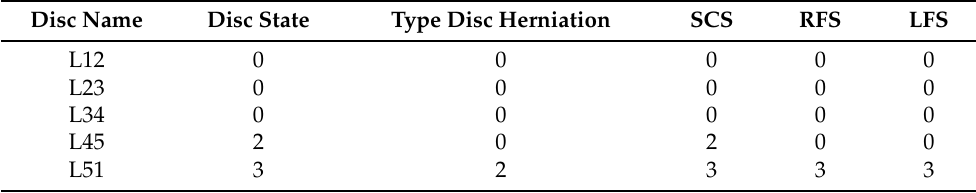
Table 4. An example of the process of the grading data taken from the PACS